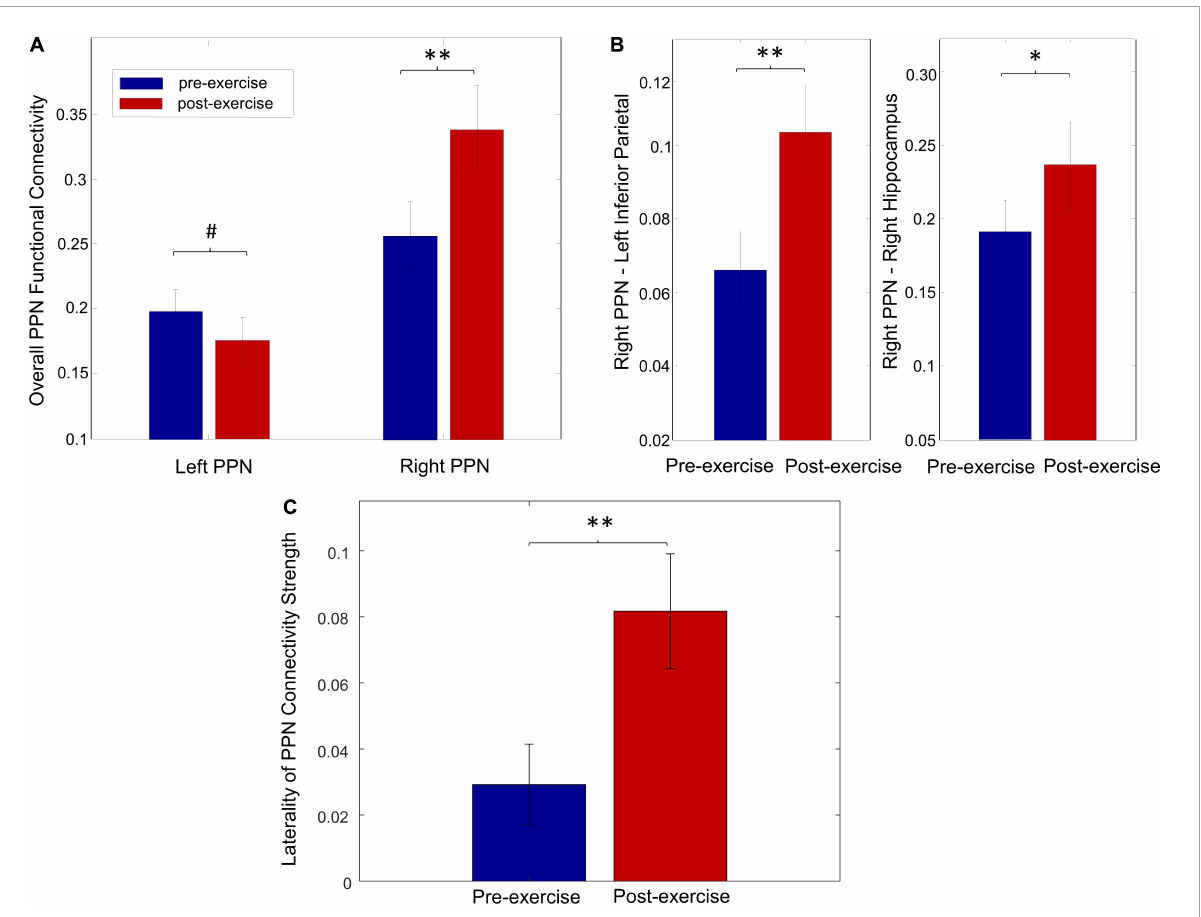
FIGURE5 Exercise-induced changes on PPN functional connectivity. (A) The overall functional connectivity of the left and right PPN for pre-exercise and post-exercise. (B) The individual functional connectivity of the right PPN for pre-exercise and post-exercise. (C) The laterality of PPN connectivity strength for pre-exercise and post-exercise ( # p > 0.1, * p < 0.1, ** p <